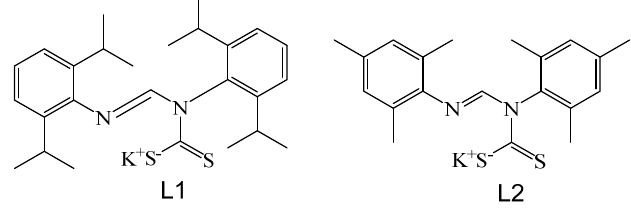
Figure 1. General structures of ligands L1 and L2.